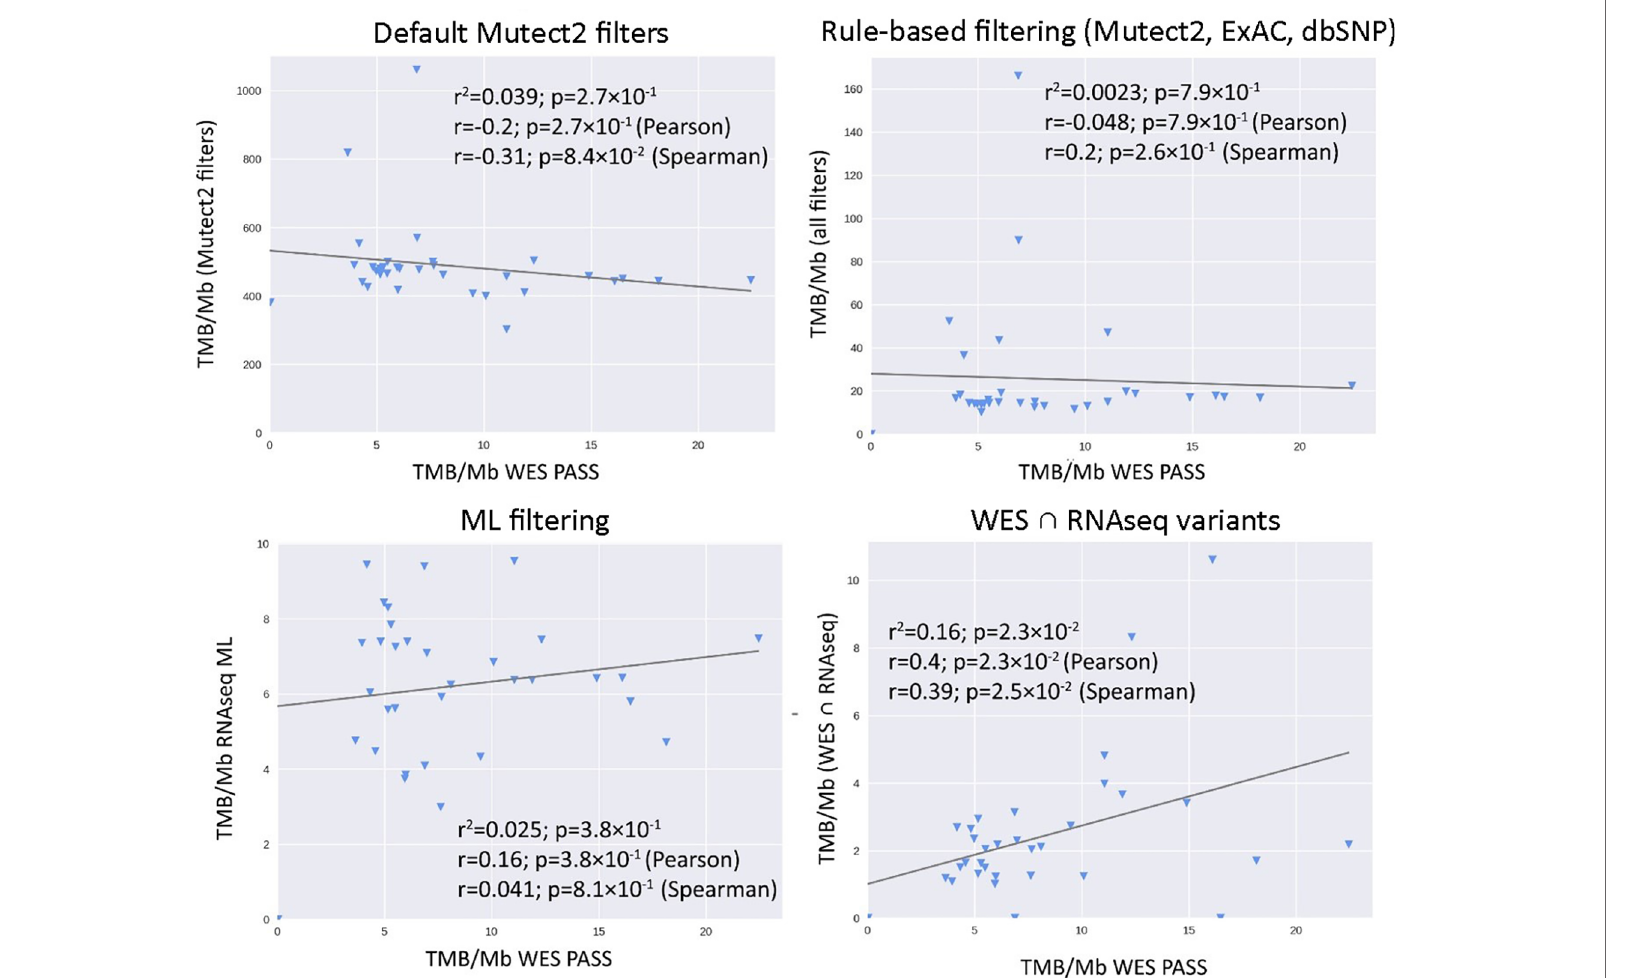
FIGURE 8 | Correlations between RNAseq- and WES-derived tumor mutation burden estimates in experimental low coverage FFPE dataset, n =